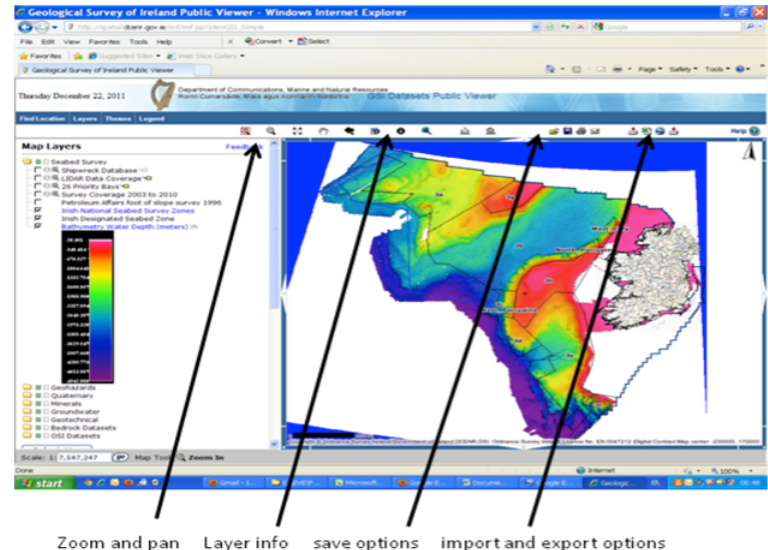
Figure 2: GSI data viewer.